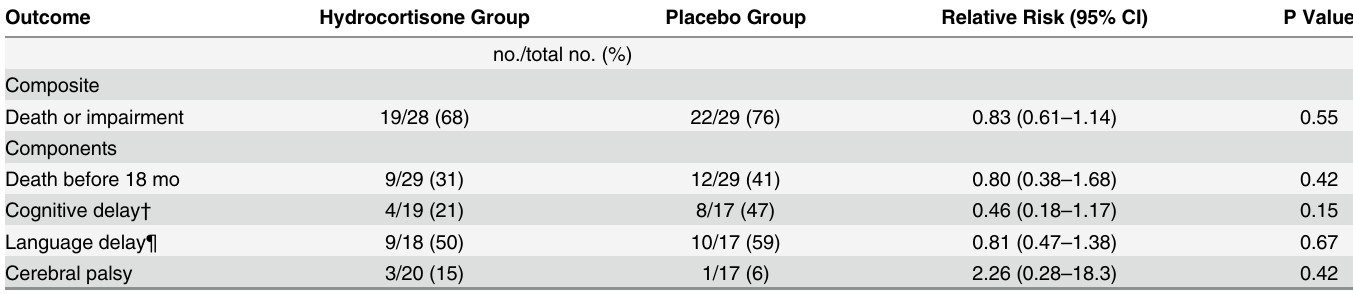
Table 2. Primary Outcome of Death or Neurodevelopmental Impairment at Corrected Age of 18 to 22